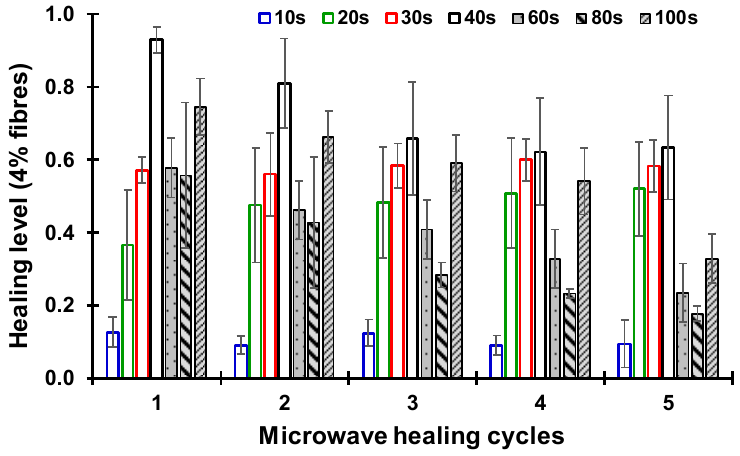
Figure 9. Healing levels of asphalt mixtures with 4% of fibres, depending on the heating time (includes results of healing level at 60 s, 80 s and 100 s from the previous research of Norambuena-Contreras and García [17]).